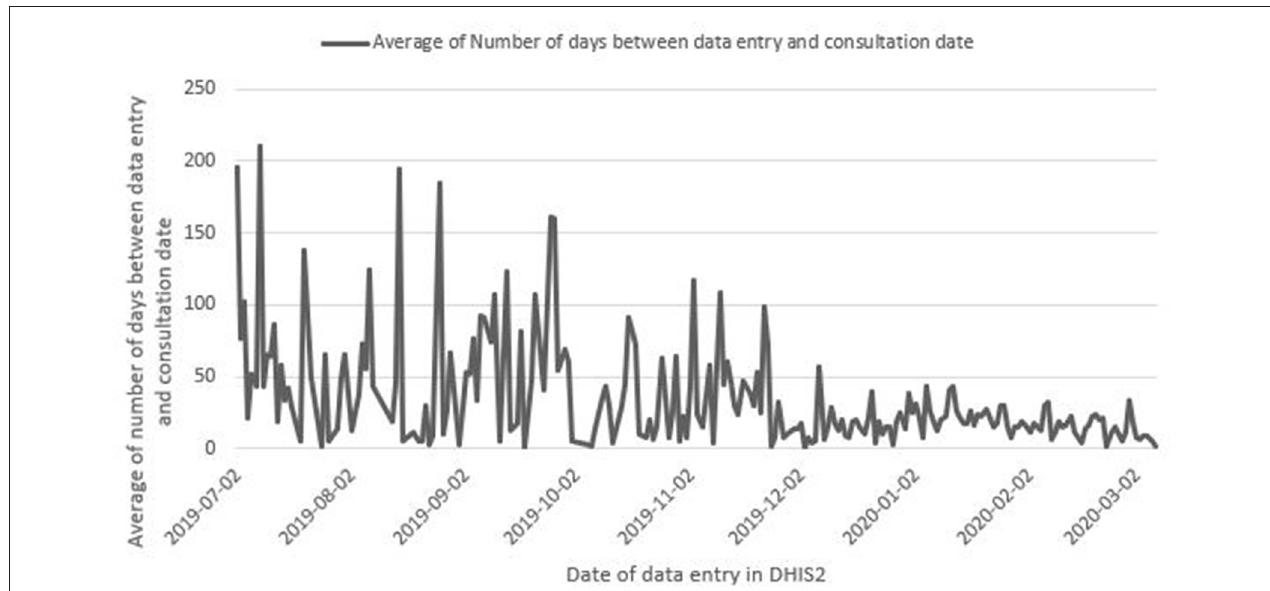
FIGURE 5 | Average number of days between consultation date of the patient and data entry in DHIS2 for measles case notifications, Guinea, June 30, 2019-March 7, 2020. Data are from Guinea’s national DHIS2, accessed June 10,